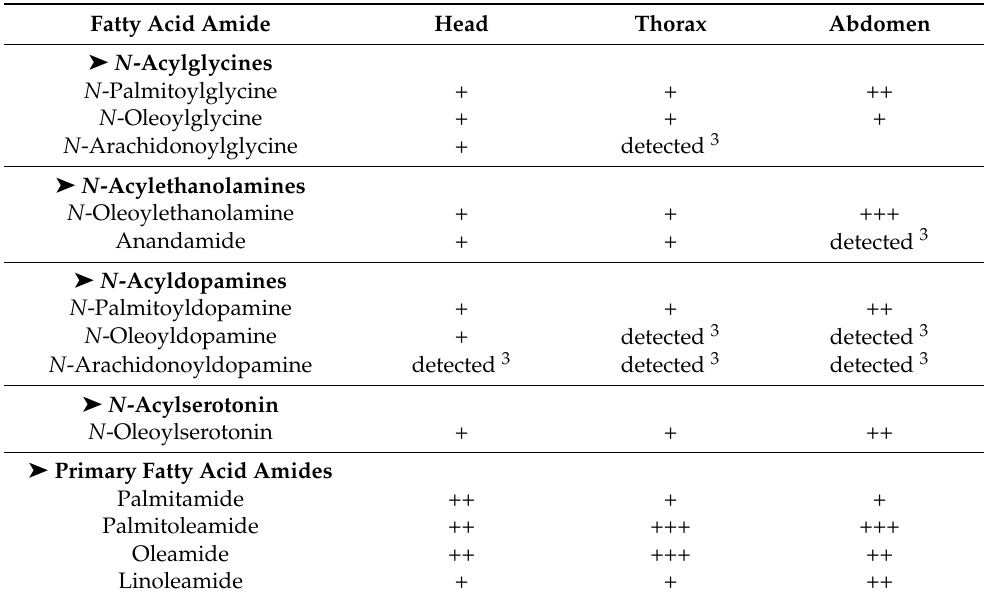
Table 3. Fatty acid amides produced by Apis mellifera 1,2